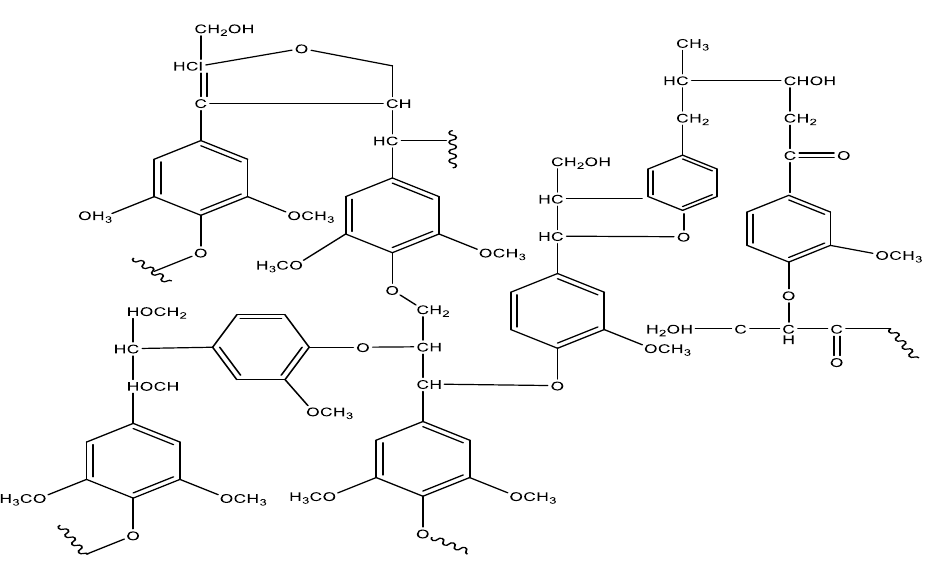
Figure 11. Lignin proposed by Adler (1977) (adapted from [87]).